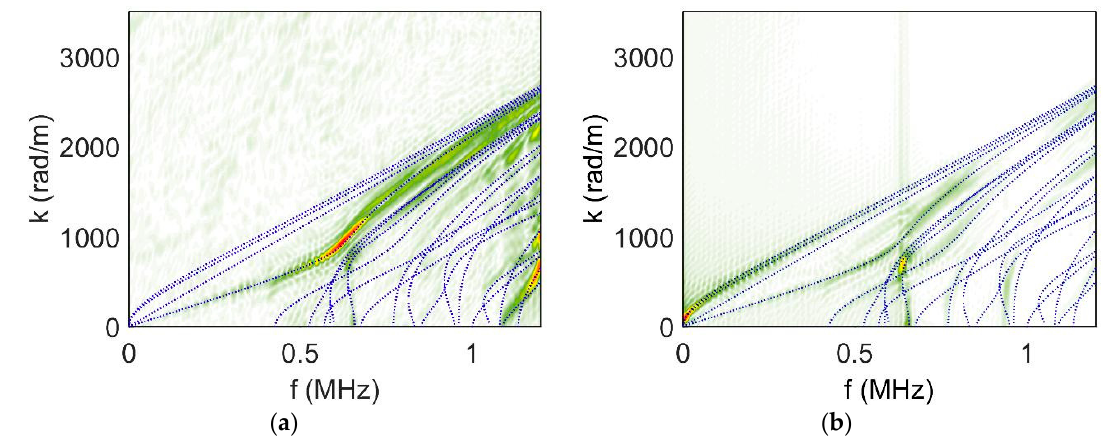
Figure 12. 2DFT (wavenumber k versus frequency f ) of simulated signals for the EPL3 specimen stimulated by sources D 1 (M x = 500 N ∙μ m, 0 mm, 0.1 μ s) ( a ), and D 2 (M x = 100 N ∙μ m, 0.95 mm, 1 μ s) ( b